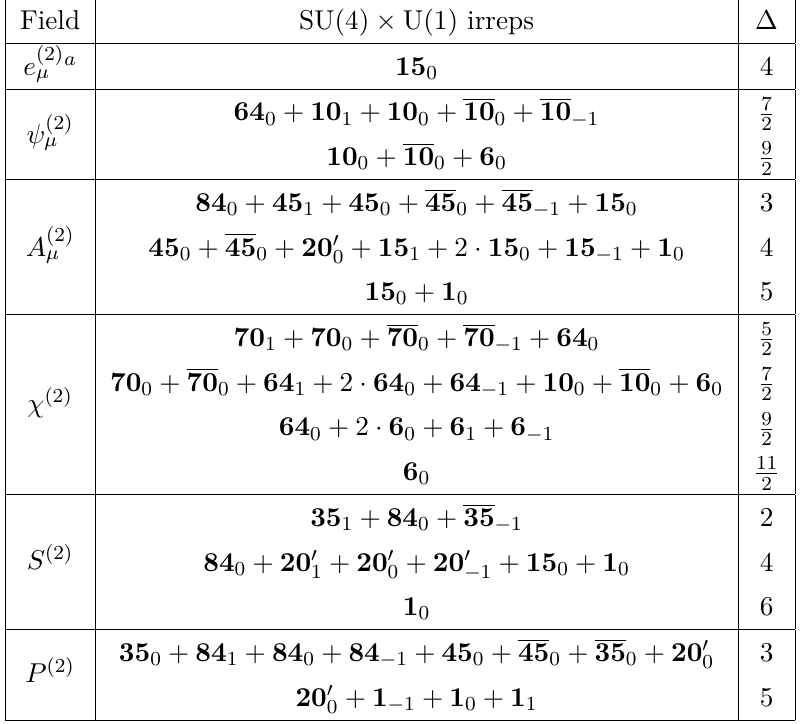
Table 9 . The KK spectrum for level n = 2 of 11d supergravity on AdS 4 × S 7 / Z 4 with the periodic spin